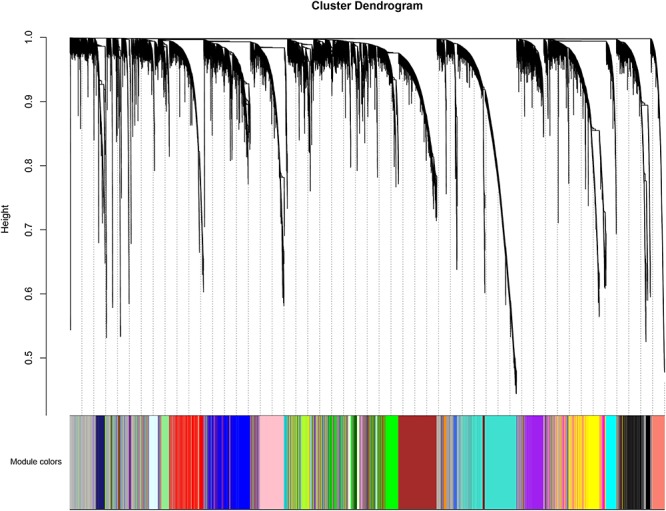
The cluster Dendrogram of the WGCNA co-expression network. The genes and miRNAs were clustered in 38 modules. Each module was marked with one color. Except for the gray module, which included many un-classified members, the turquoise module contained a maximum 1,943 members, while a minimum of 33 members were included in the skyblue3 module. In addition, we found 31 modules contained at least one miRNA and the maximum amount of 297 miRNAs were in the midnight-blue module.